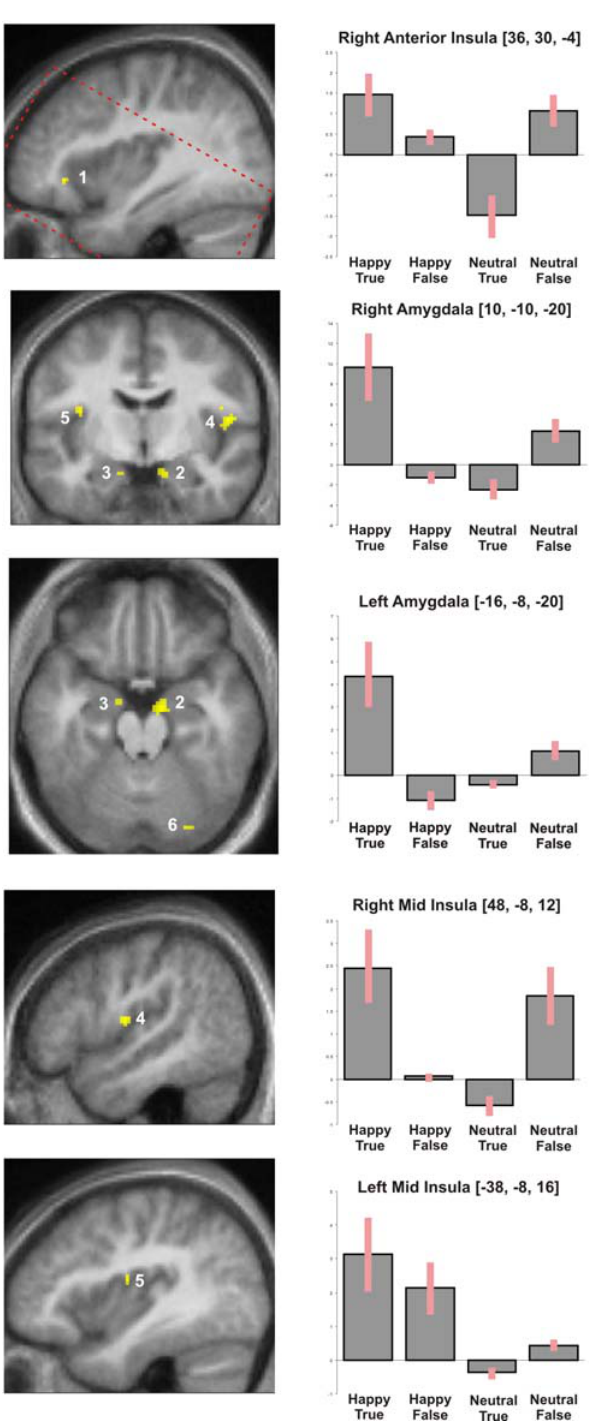
Figure 2. Neural Interaction of Emotion and Feedback Veracity. Left; Significant interactions of emotion (happy neutral) and feedback (true false) were observed on neural activity within; 1) right anterior insula, 2) right amygdala, 3)left amygdala, 4)right mid insula, 5) left mid insula and 6) posterior dorsal cerebellum. Functional interactions are projected onto a normalised mean structural image calculated from each individual subjects structural T1 weighted image. Dashed bounding box illustrates volume of acquired T2 data. Right; Contrast estimates at the illustrated regions are displayed.